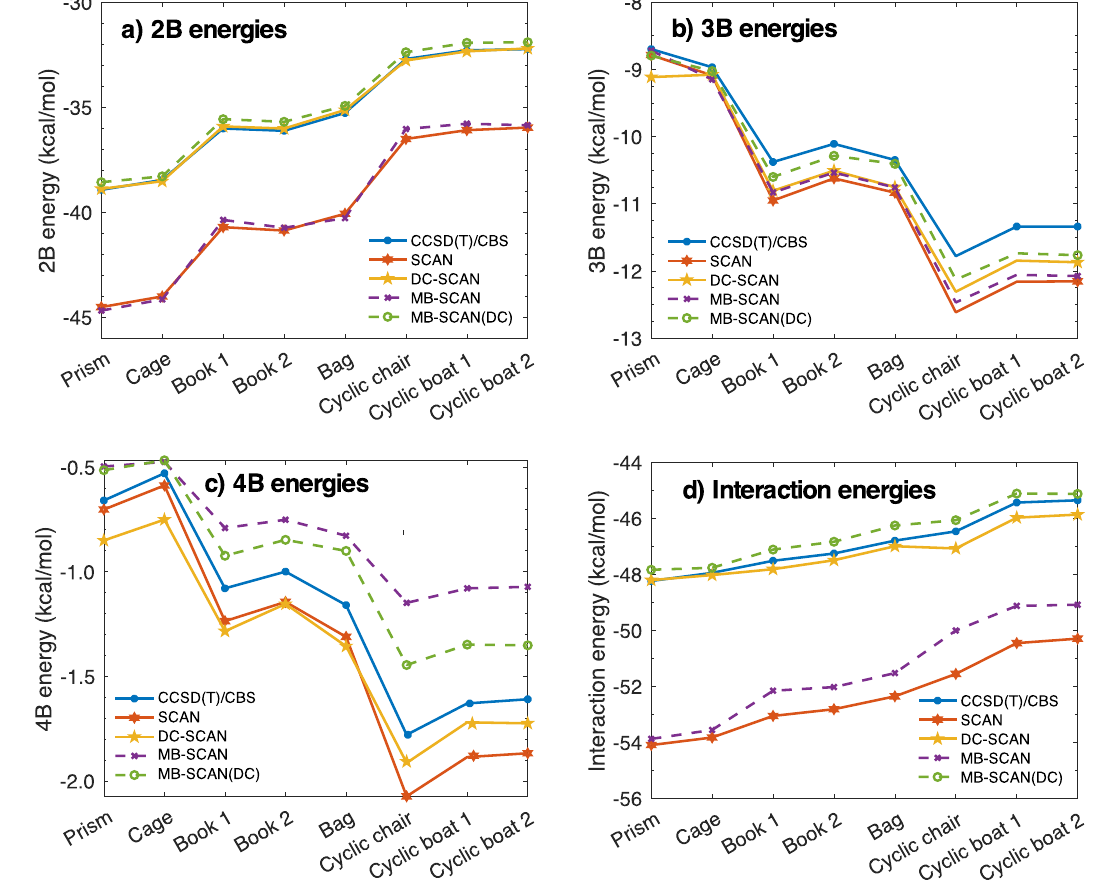
Fig. 4 Many-body and interaction energies for the isomers of the water hexamer. a 2-body (2B), b 3-body (3B), c 4-body (4B) and d total interaction energies of the fi rst eight isomers of the water hexamer calculated using SCAN, DC-SCAN, MB-SCAN, MB-SCAN(DC), along with the CCSD(T)/CBS reference values of ref. 78 . level, with MUEs of 4.59 and 0.08 kcal/mol associated with SCAN energy functions (PEFs) described in the “ Methods ” section. Also and DC-SCAN, respectively. The MUEs reduce to 0.59 and shown for reference are the CCSD(T)/CBS values reported in 0.38 kcal/mol at the 3-body level. The comparisons shown in ref. 78 . The errors relative to the reference CCSD(T)/CBS values for both many-body and interaction energies which are associated Fig. 4a, b demonstrate that both the MB-SCAN and MB- with the SCAN and DC-SCAN functionals and the corresponding SCAN(DC) PEFs are able to quantitatively reproduce the 2-body MB-SCAN and MB-SCAN(DC) PEFs are shown in Supplemen- and 3-body energies calculated ab initio with the corresponding tary Fig. 7. As already discussed in the case of the octamer SCAN and DC-SCAN functionals. Since, by construction, n B isomers, density-driven errors are most pronounced at the 2B energies with n > 3 in the MB-SCAN and MB-SCAN(DC) PEFs